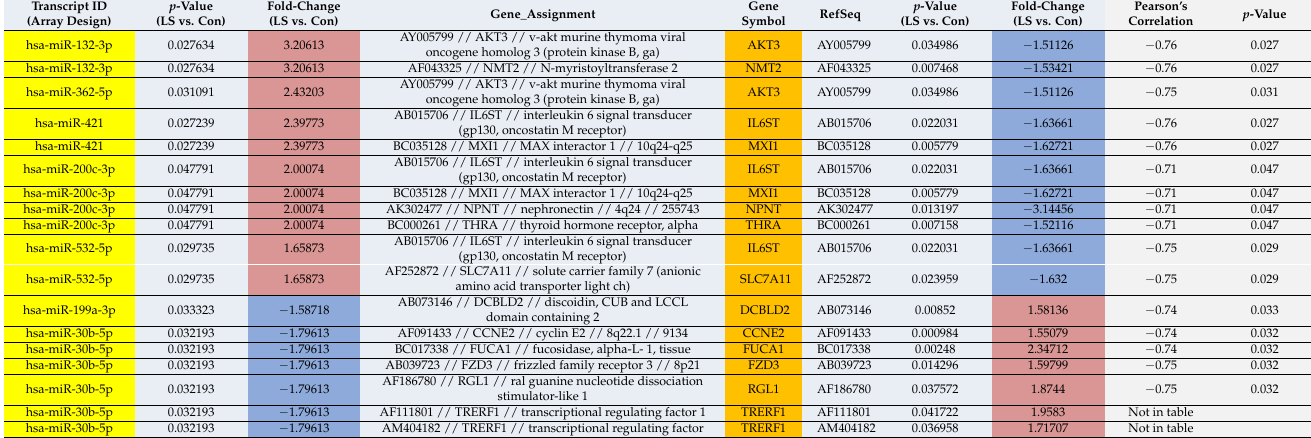
Table 1. Sixty-eight human miRs were differentially expressed in LS vs Control (FC = 1.5 and p < 0.05). Data was combined with the 130 differentially expressed genes from the mRNA analysis (same cutoff). Only miR-gene targets that were negatively correlated were selected. First three rows represent miR information, including miR name, p -value and fold- change in LS vs. control (up-regulation in pink and down-regulation in gray). The additional columns present miR-targets from gene expression experiments, including p -value and fold-change as revealed above. Pearson’s correlation analysis presents negative correlations between miR and gene fold-change differences with significant p -values (last column).